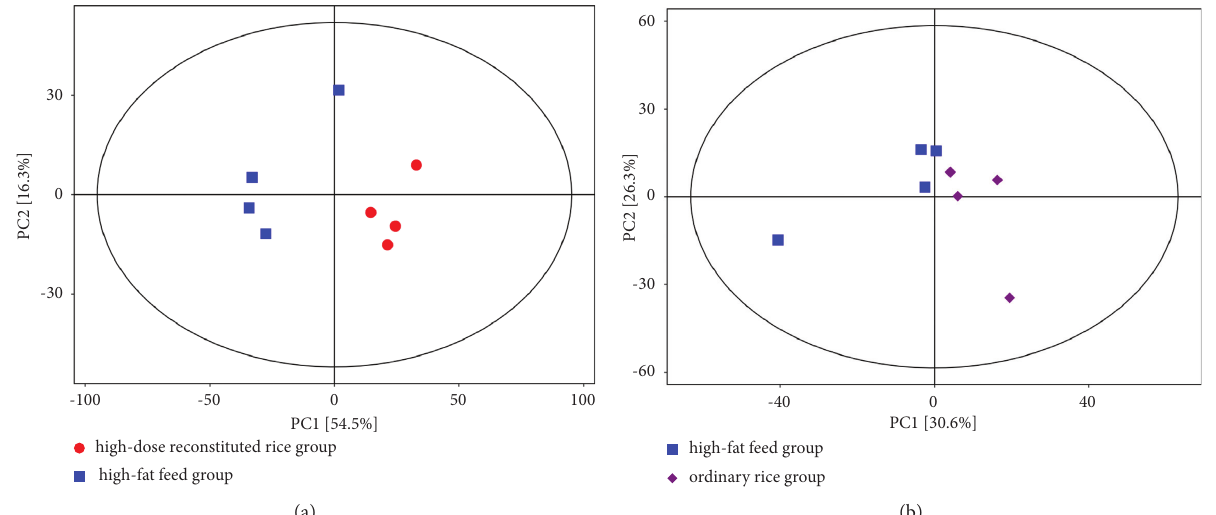
Figure 1: PCA analysis of blood samples from rats under different feedary interventions (positive ion mode). (Remarks: (a) high-dose reconstituted rice group vs. high-fat feed group; (b) high-fat feed group vs. ordinary rice group; and (c) high-dose reconstituted rice group vs. ordinary rice